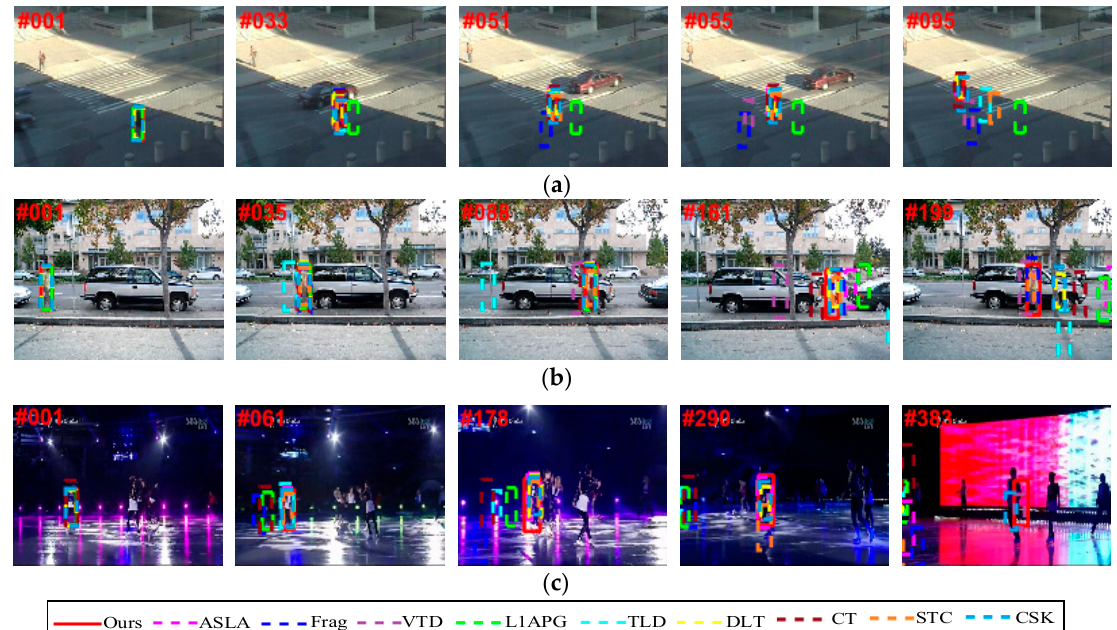
Figure 9. Screenshots of some sampled tracking results, where objects undergo deformations. ( a ) Crossing with deformation and illumination variation; ( b ) David3 with deformation and occlusion; ( c ) Skating1 with deformation and illumination variation.